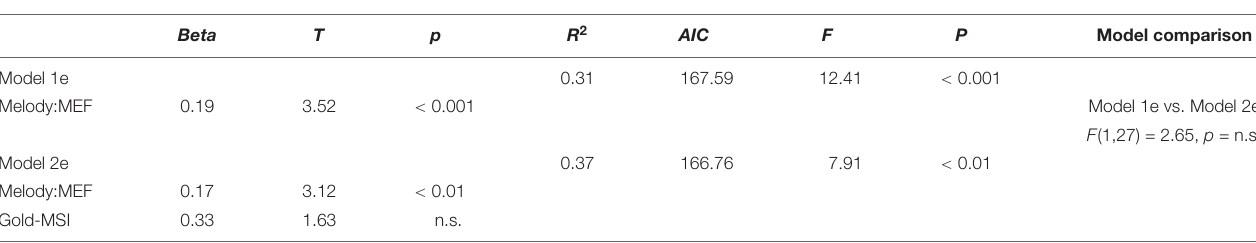
FIGURE 3 | Interactions between MEF and musical abilities in predicting phonological awareness scores; Rhythm, Rhythm Perception; Synch, Synchronization (N.B. smaller scores in the Synchronization task indicate better performance). Means and standard deviations of all variables and unstandardized regression coefficients of both direct and interaction effects were used to generate points in the graphs that represent high and low performance in each of the independent variables. TABLE 9 | Summary and comparisons between Models 1e and 2e predicting grammar.